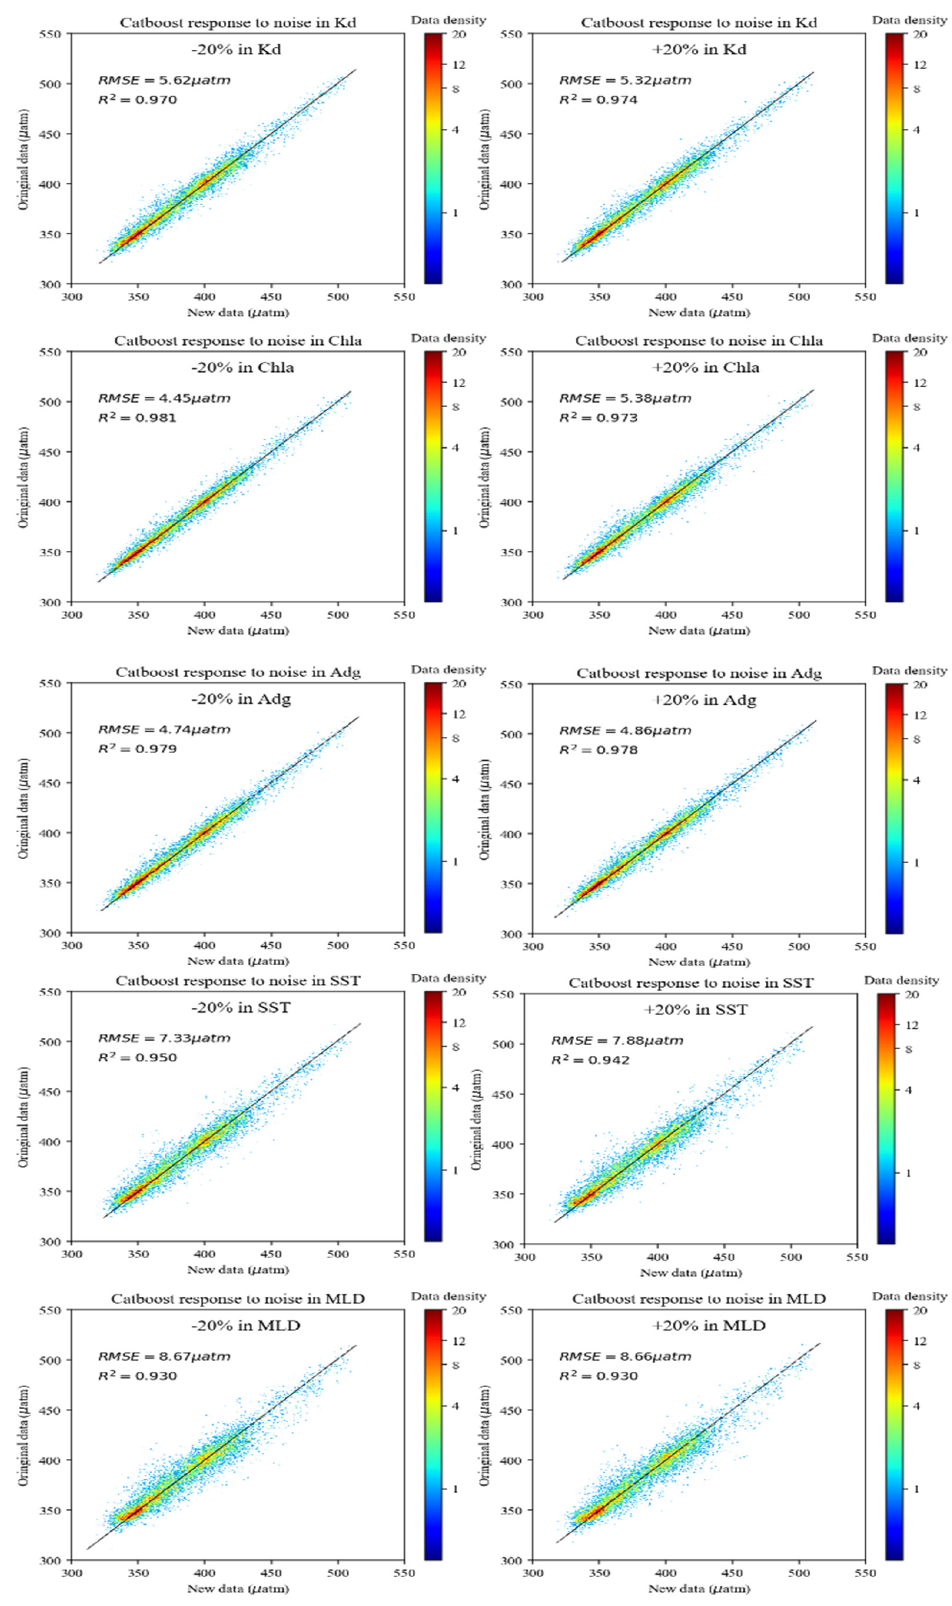
Figure 5. CatBoost pCO 2 model sensitivity to changes in the input SST, Adg, Chla, Kd and MLD, based on the dataset used to develop the pCO 2 model.